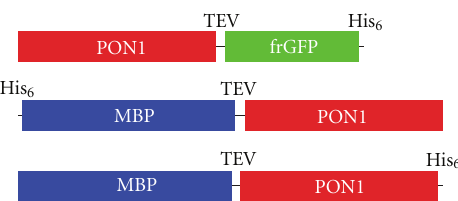
Figure 2: Schematics of the fusions used in this study. PON1, paraoxonase-1 variant; TEV, TEV protease site; frGFP, folding reporter GFP; His 6 , hexahistidine tag; MBP, maltose-binding pro-